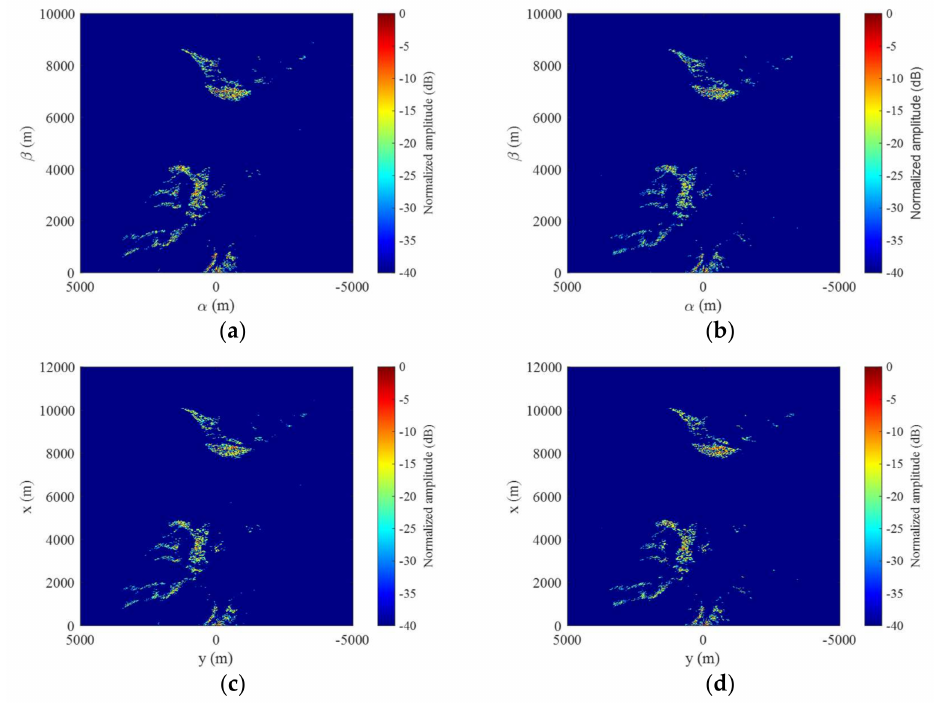
Figure 18. MF-PB-SAR images of the snow mountains in Spitsbergen ( a , b ) on the α -o- β plane and ( c , d ) on the x-o-y plane. The left sub-figures and right sub-figures correspond to the data sampled in 22 September and 4 October,